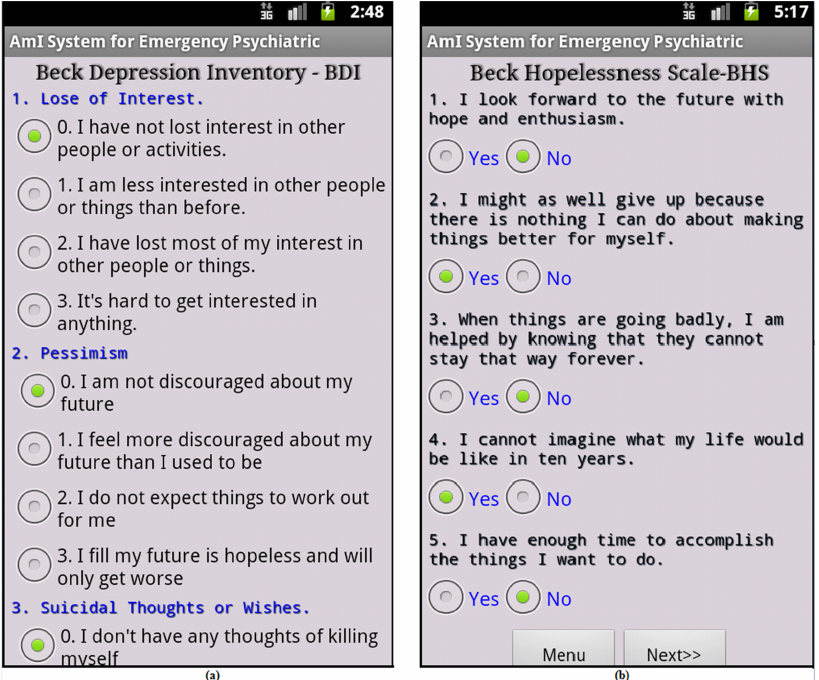
Figure 12. The benchmark questionnaire prototype: ( a ) Beck Depression Inventory (BDI) [10]; and ( b ) Beck Hopelessness Scale (BHS)